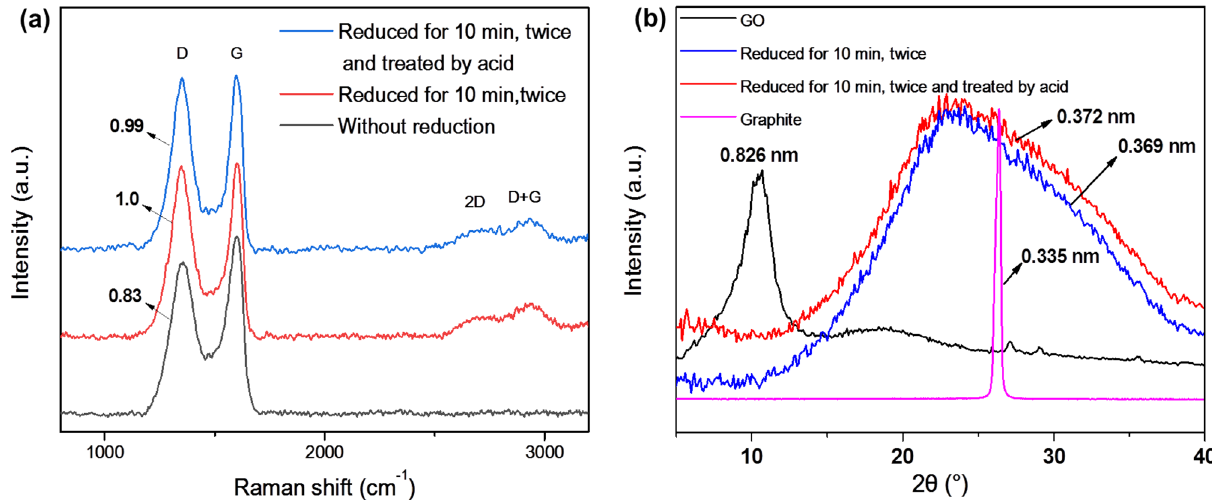
Figure 4. ( a ) Raman spectra (at 532 nm) and ( b ) XRD spectra of GO films under different treatments.